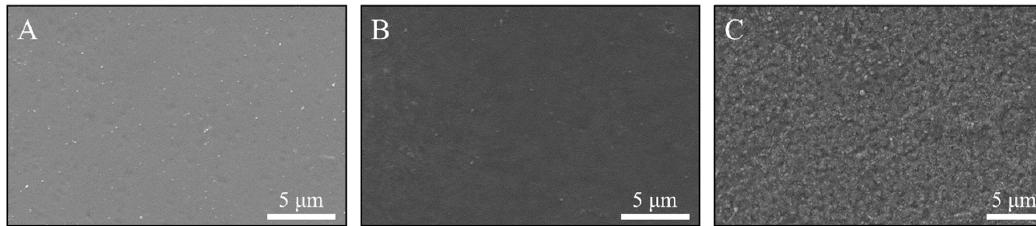
Figure 2. Representative SEM micrographs displaying the surface morphology of HA and SiHA thin films where ( A ) is an as deposited thin film on a CPTi substrate, ( B ) annealed at 600 °C in flowing argon for 2 h and ( C ) 700 °C in flowing argon for 2 h. Images taken from HA samples.